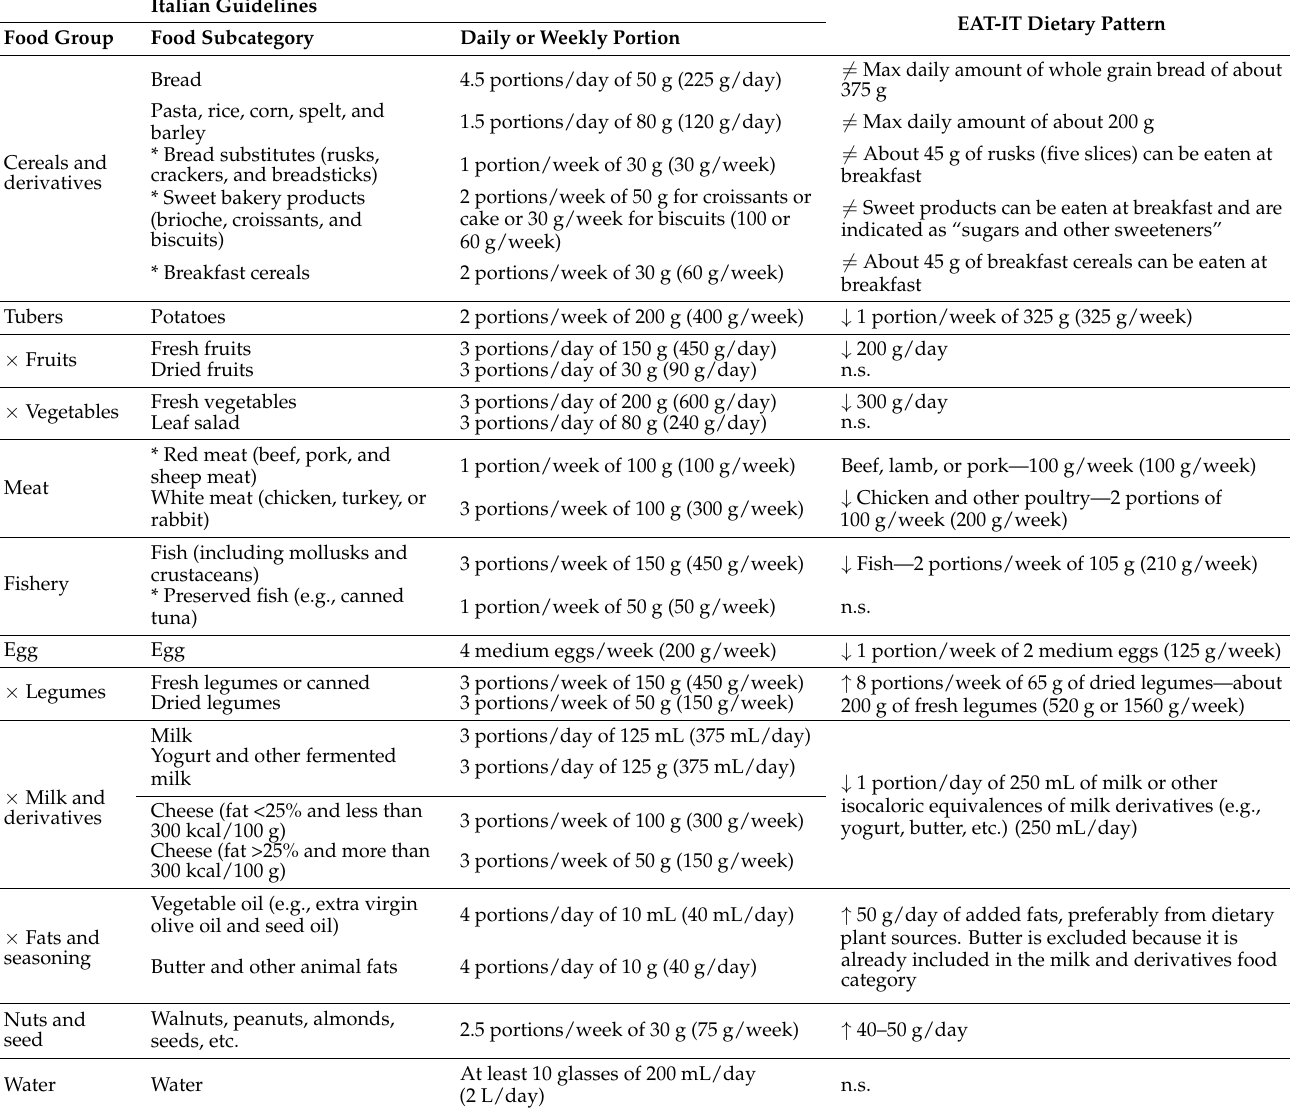
Table 3. Comparison between the suggested portions in the Italian dietary guidelines for healthy eating (for a 2500 kcal diet) and the EAT-IT dietary plan (i.e., the ELCRD tailored to consider Italian food habits), which was developed based on the planetary healthy